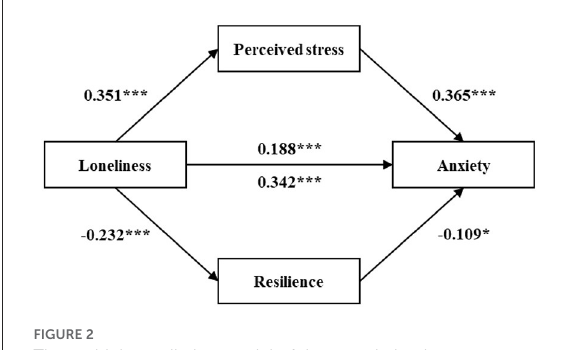
FIGURE2 The multiple mediation model of the association between loneliness and anxiety through perceived stress and resilience. *p < 0.05, ***p < 0.001 (two-tailed). All values have been standardized.